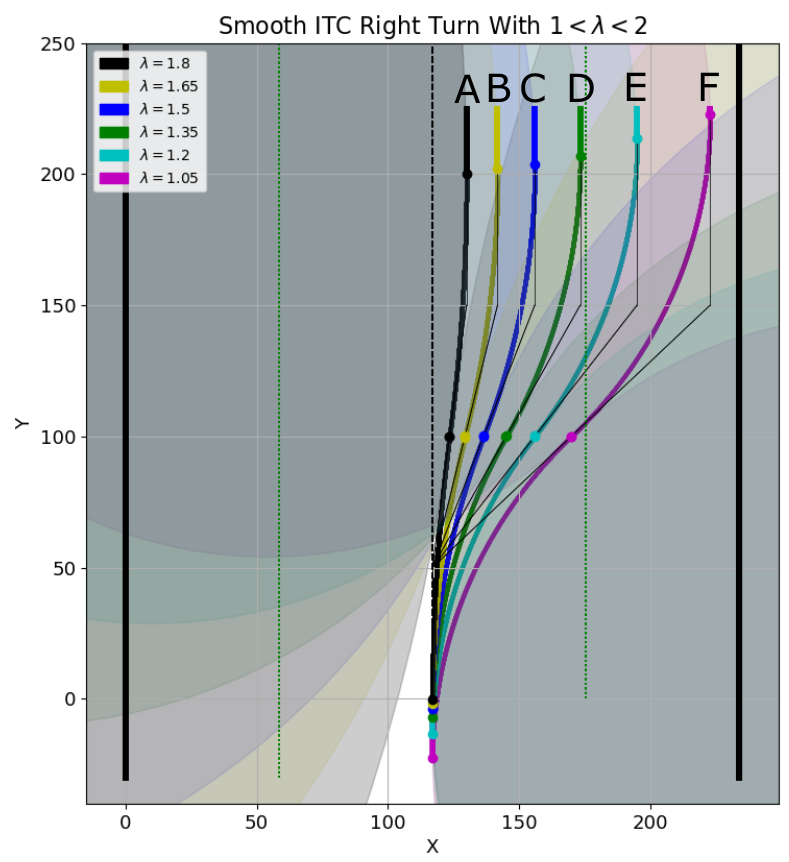
Figure 25. Effect of λ on different ITC curve generations for smooth right